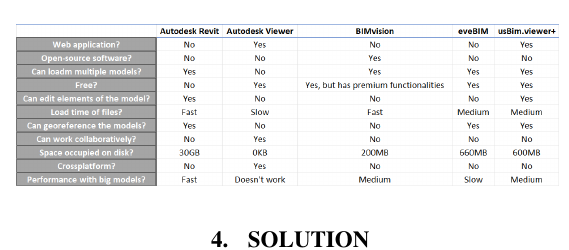
Table 1. BIM Platforms comparison